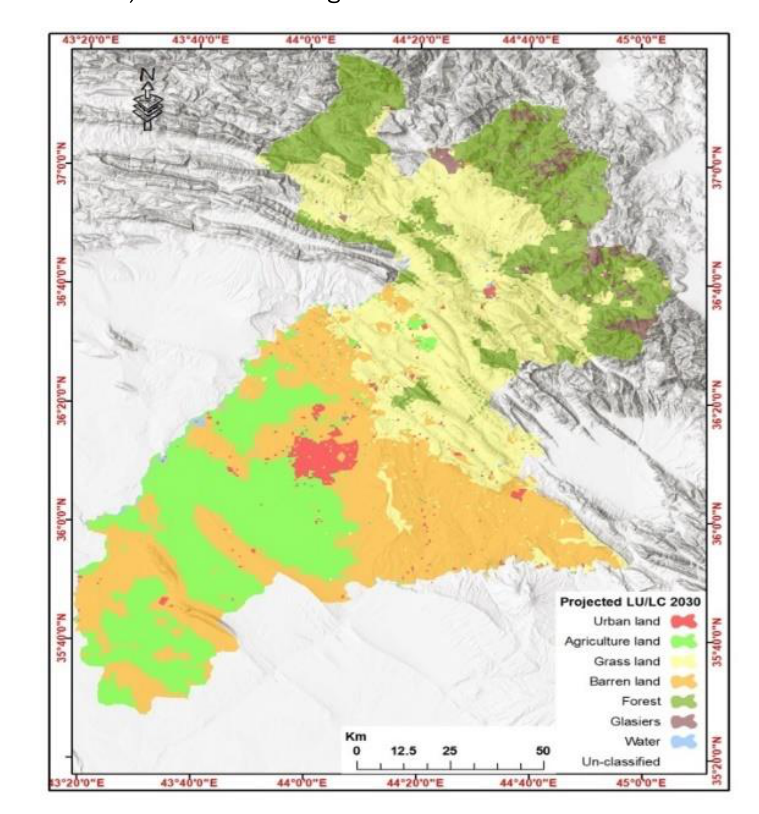
Figure 6. The predicted 2030